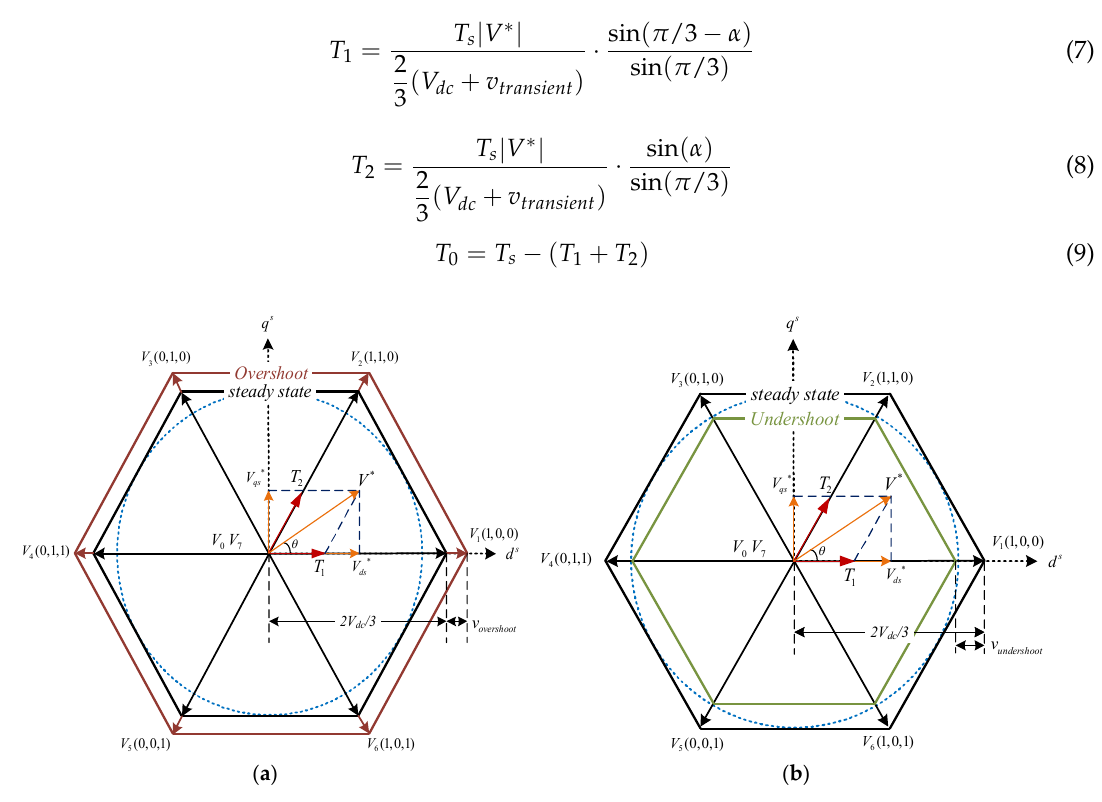
Figure 4. Changing of space voltage vector under transient state in ( a ) overshoot and ( b ) undershoot. Therefore, the switching time calculated from Equations (1)–(3) and (7)–(9) has an error. The error in Sector 1 is shown in Equations (10) and (11).